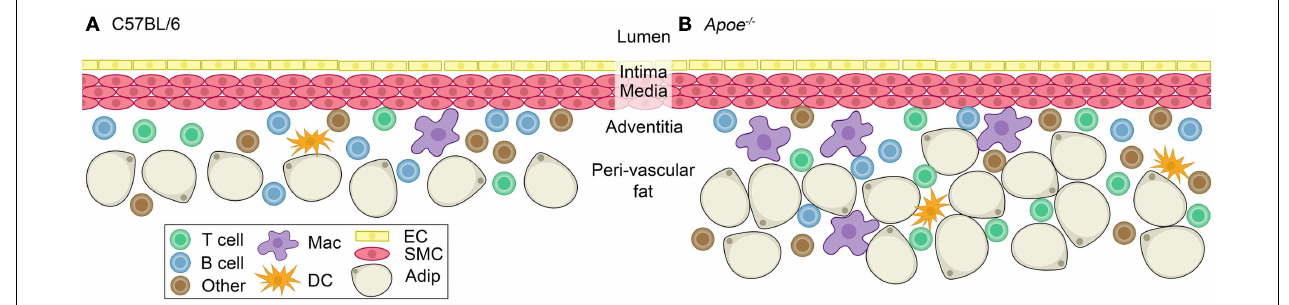
FIGURE 3 | Immune cells at homeostasis in the adventitia of C57BL/6 and Apoe − / − mice. A healthy blood vessel is composed of an endothelial layer, an intima in between the endothelial layer and smooth muscle cell layer, and a smooth muscle cell layer (media) surrounded by the adventitia and peri-vascular fat. (A) The adventitia of a C57BL/6 mouse containsT cells, B cells, macrophages, dendritic cells, and others (neutrophils, natural killer cells, and natural killerT cells; Galkina et al., 2006; Jongstra-Bilen et al., 2006). (B)